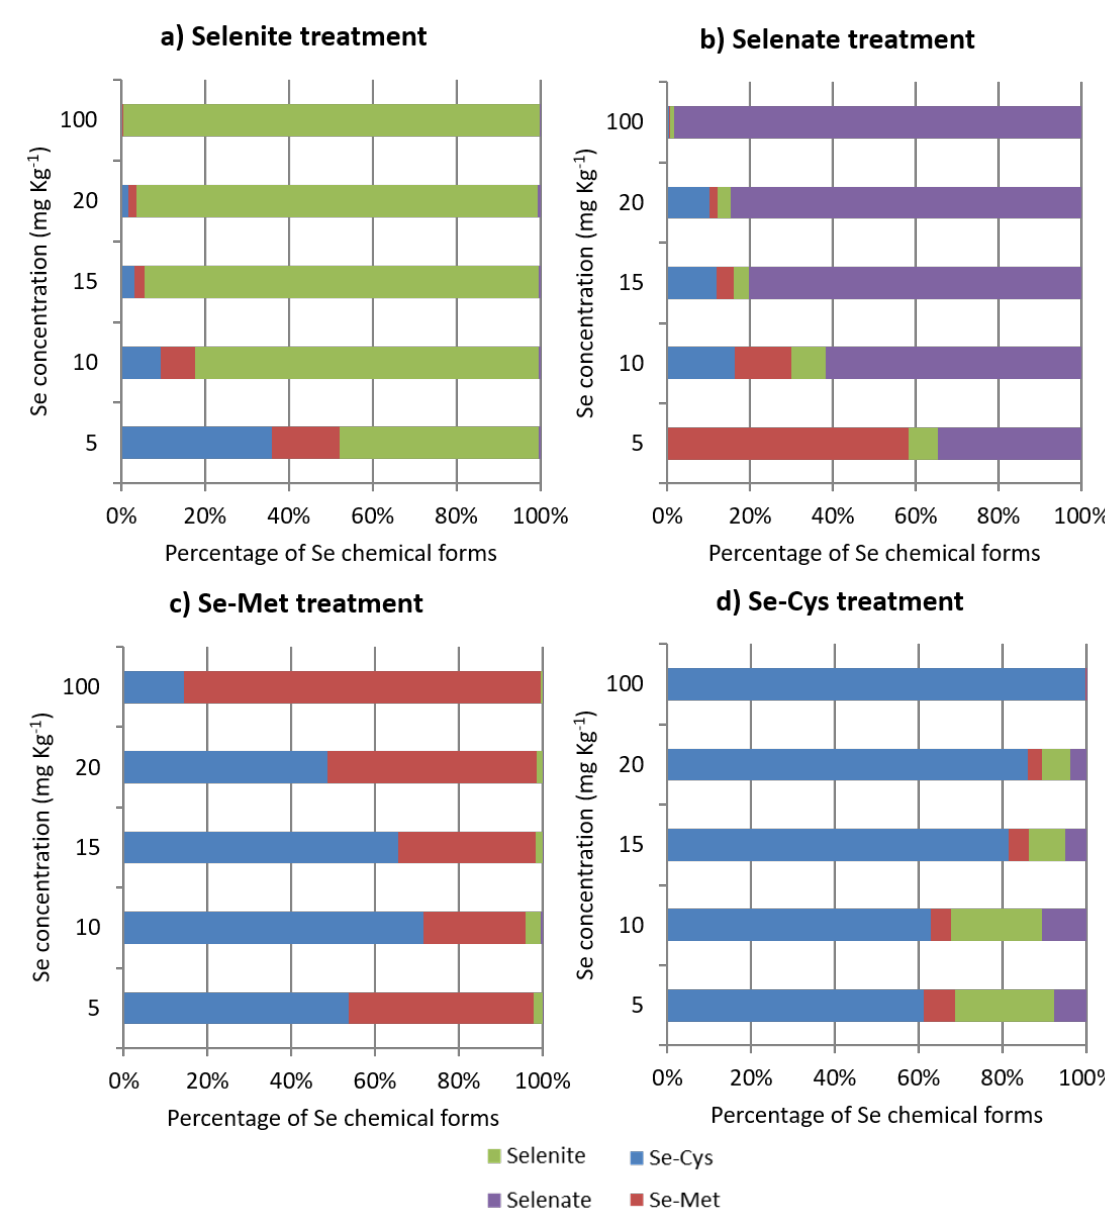
Figure 4. Selenium (Se) speciation data showing different Se chemical forms and their distribution after 10 days of incubation in the growth medium (potato dextrose agar) in the presence of Fusarium proliferatum strain PG-CH1 and following the application of increasing Se concentrations (5, 10, 15, 20, and 100 mg kg − 1 ) as sodium selenite (selenite; a ), sodium selenate (selenite; b ), selenomethionine (Se-Met; c ), and selenocystine (Se-Cys; d ).